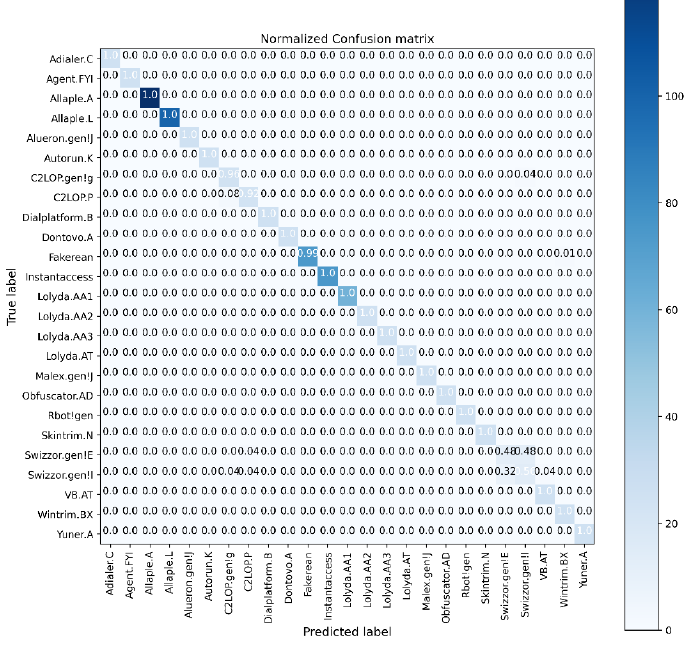
Figure 11. Normalized confusion matrix for classification of 25 malware classes.